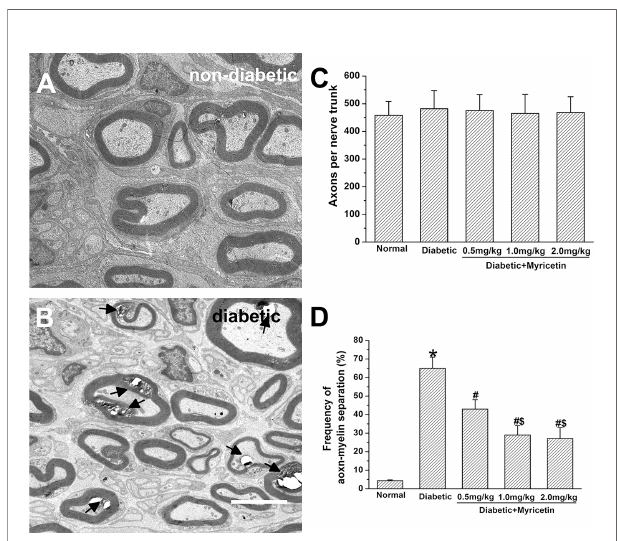
FIGURE 2 | The bene fi cial effect of myricetin on nerve morphology in diabetic rats ( n = 10 for each group). A signi fi cantly increased axon – myelin separation was noted in diabetic myelinated axons (A, B) . Myricetin at different doses has little effect on axonal number in saphenous nerve (C) . Application of myricetin signi fi cantly ameliorated the increased frequency of axon – myelin separations in diabetic nerves (D) . * p < 0.05 for the comparison to the normal group, # p < 0.05 for the comparison to the saline-treated diabetic rats. $ p < 0.05 for the comparison to the diabetic rats treated with myricetin at 0.5 mg/kg.